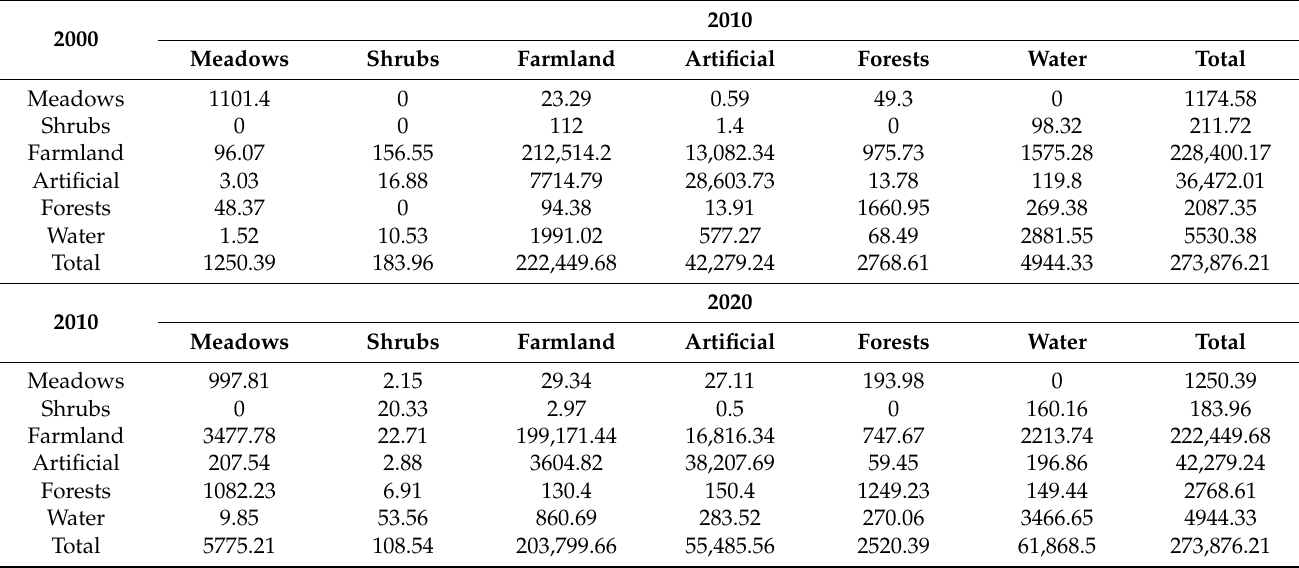
Table 5. Land use type area transfer matrix (unit: km 2